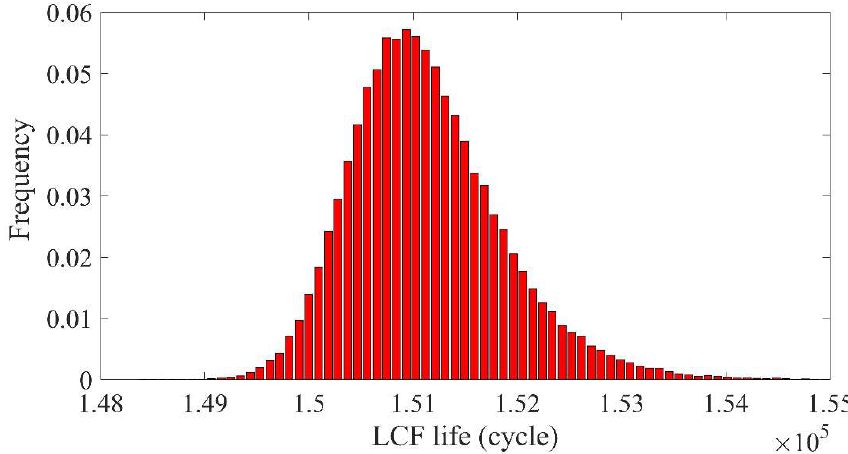
Figure 14. The frequency histogram of the LCF life.